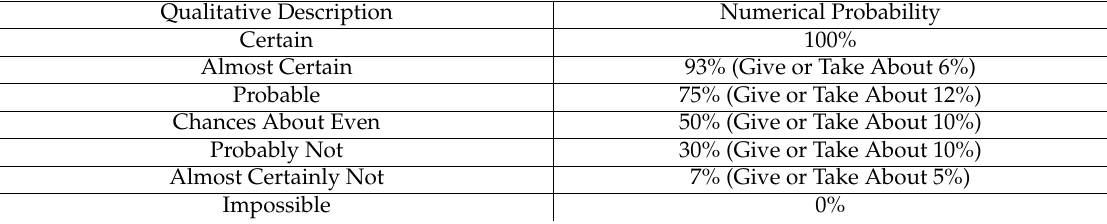
Figure 9. Likelihood scale (adapted from CIA, US).